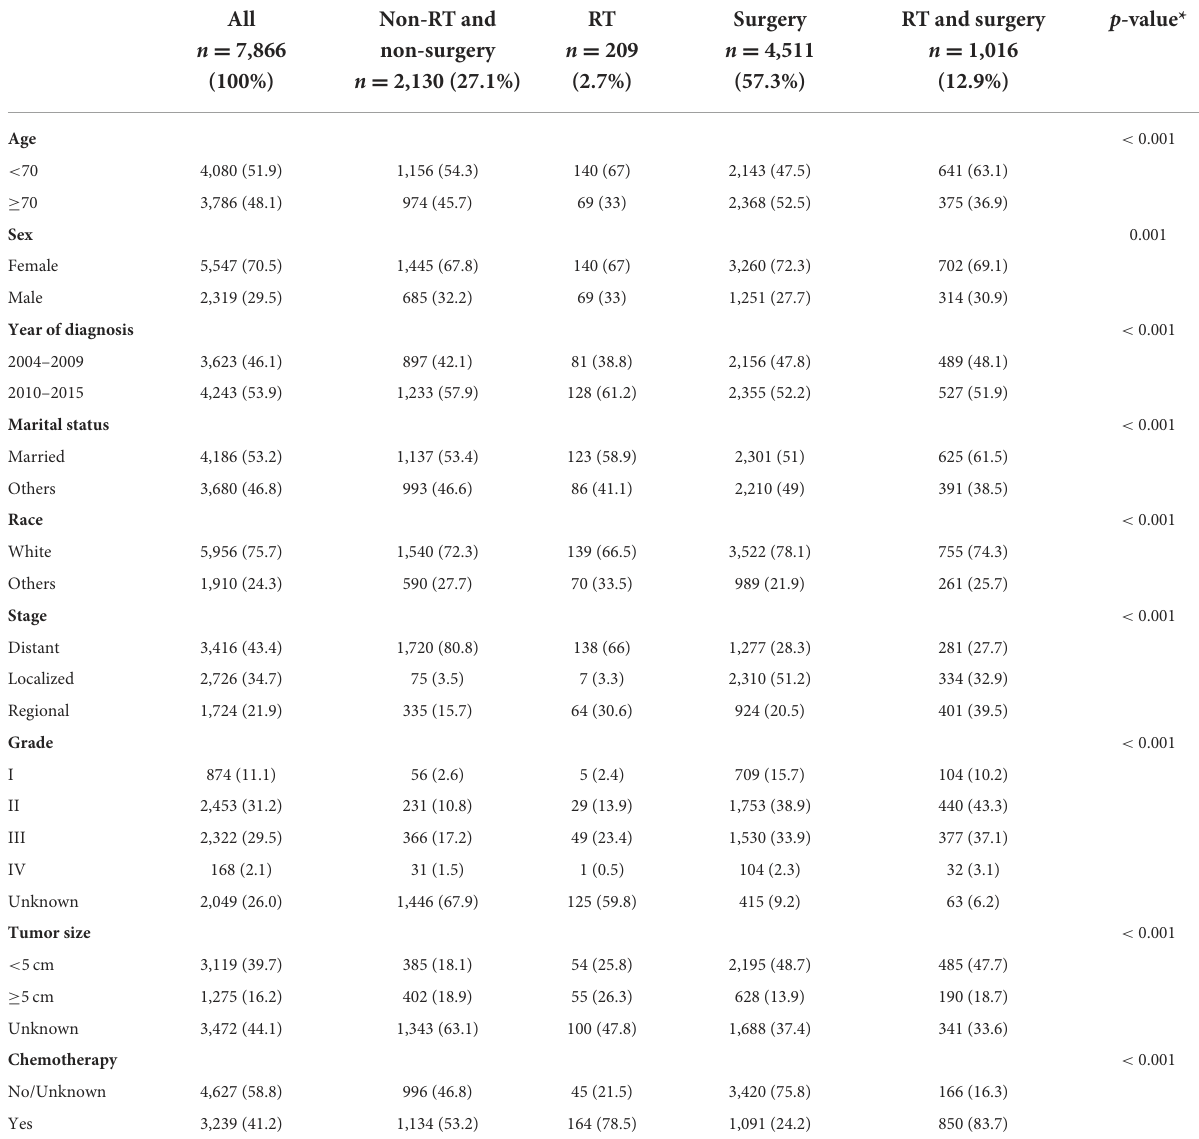
TABLE 1 Baseline characteristics of gallbladder cancer